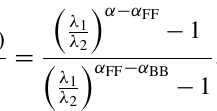
Table 1. PM 2 . 5 sampling campaigns carried out on the Monserrate site; N stands for the number of filter